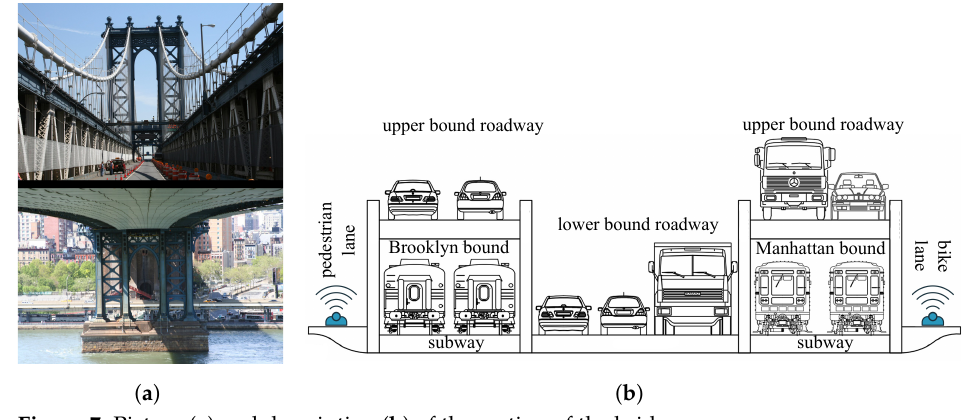
Figure 7. Picture ( a ) and description ( b ) of the section of the